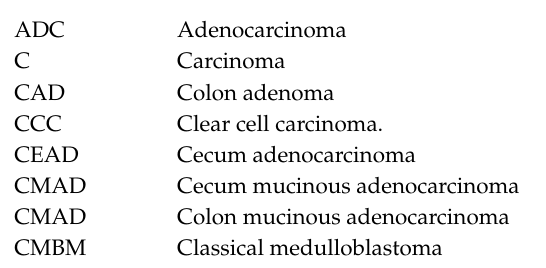
Table S1: Dataset query results of BMP5 expression in cancer and normal tissue samples derived from GENT database. Table S2: The significant changes of BMP5 expression in normal tissues and cancer tissue were derived from the ONCOMINE database. Table S3: The relationship between BMP5 expression and survival in various cancer patients. Table S4: Fold change values of functional protein partners of BMP5 (Oncomine). Table S5: Gene ontology (GO) terms obtained from genes positively correlated with BMP5 (GOnet). Table S6: List of correlated genes of BMP5 in five cancer types obtained from R2: Genomics Analysis and Visualization Platform. Table S7: Analysis of positively correlated genes of BMP5 using the R2: Genomics Analysis and Visualization Platform. Figure S1: Copy number alteration frequency of each gene of the BMP5 cluster from GeneMANIA and STRING database. A total of 17815 patients / 18300 samples in 30 studies were queried. Queried genes were altered in 6751 (38%) of queried patients in 6825 (37%) of queried samples. The alterations include inframe mutations-unknown significance (brown), missense mutations-putative driver (deep green), missense mutations-unknown significance (green), truncating mutations-putative driver (black), truncating mutations-unknown significance (grey), fusions (violet), amplifications (red), deep deletions (deep blue), no alterations (light grey) and not profiled cases (white). Figure S2: Pathway analysis of BMP5 using PANTHER pathway tool. A. A total of 49 biological processes were reported and distributed in eight categories. B. A total of 26 cellular components were reported and distributed in four categories. C. A total of 34 molecular functions were reported and distributed in seven categories. * p <